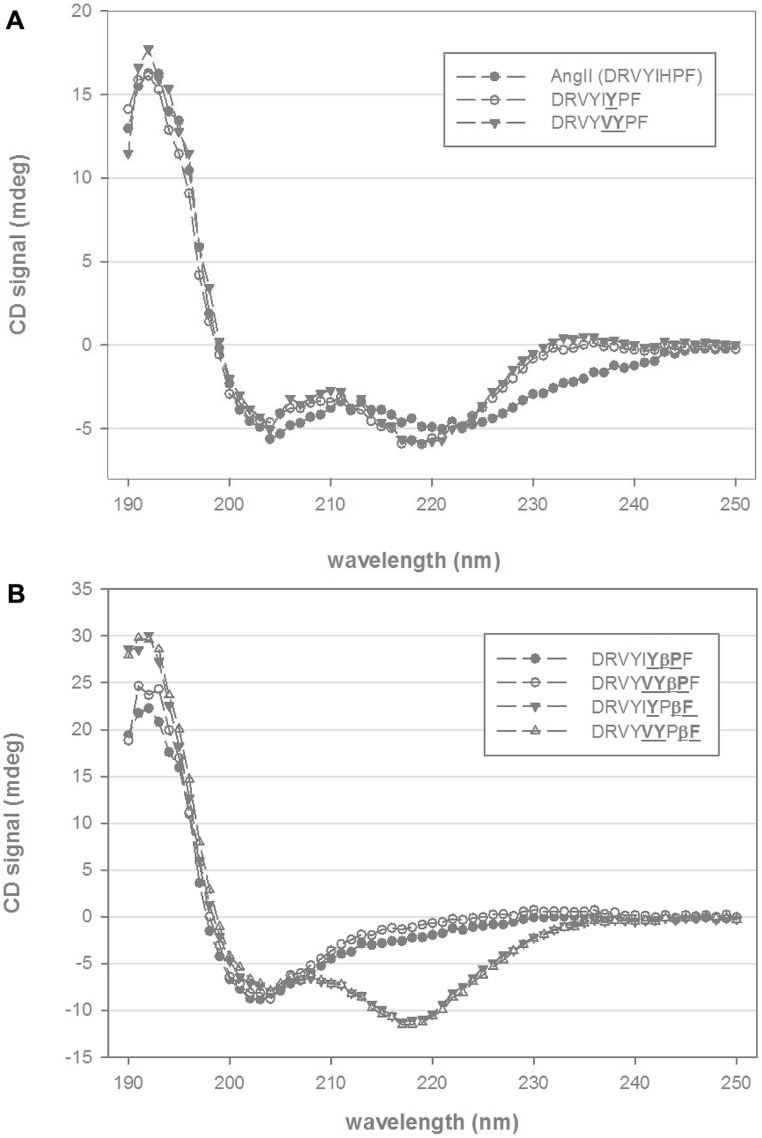
Circular dichroism (CD) spectra of chimeric AngII analogs.
(A) Shows the CD spectra of native AngII and two C-terminal non-β-amino acid analogs (DRVYIYPF, DRVYVYPF) in 25% trifluoroethanol (TFE) and 10 mM phosphate buffer. (B) Shows four β-amino acid analogs (βPro and βPhe, scissile-bond is between Pro and Phe residues AngII sequence) of DRVYIYPF and DRVYVYPF in similar mixtures of TFE and aqueous phosphate buffer.